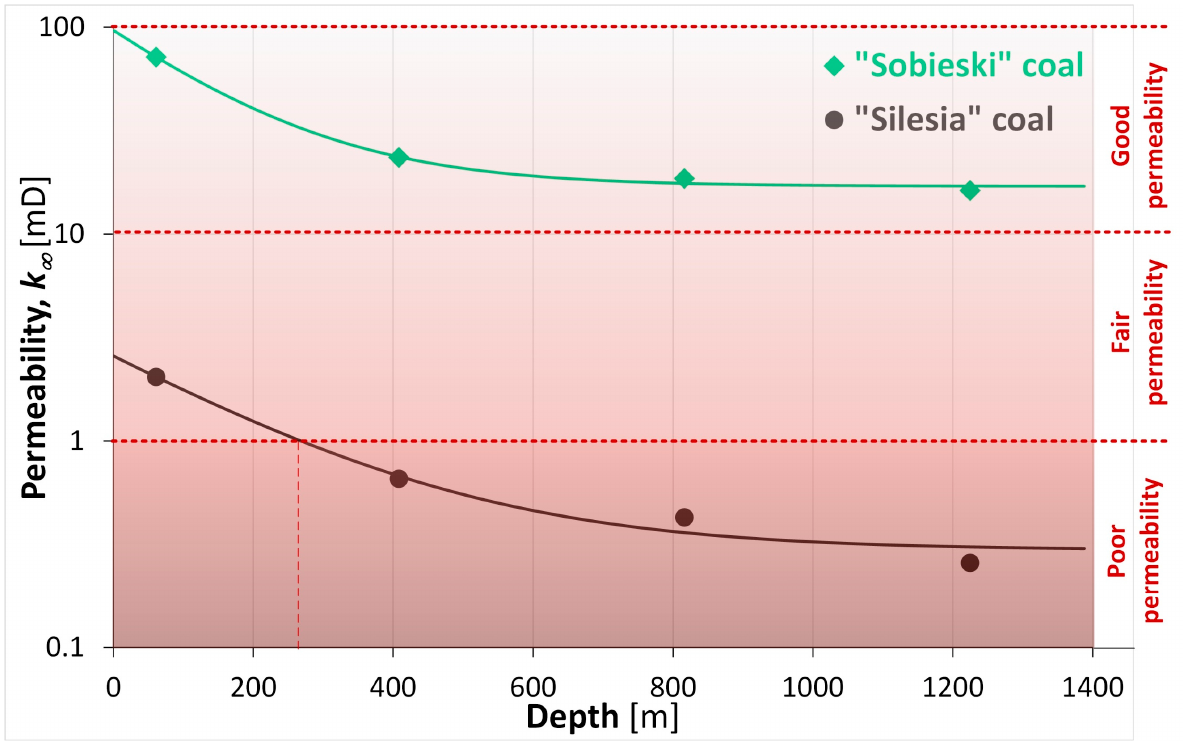
Figure 7. Coal permeability to CO 2 at different depths of the seam.